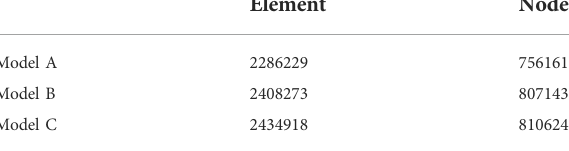
TABLE 2 Elements and nodes of meshed